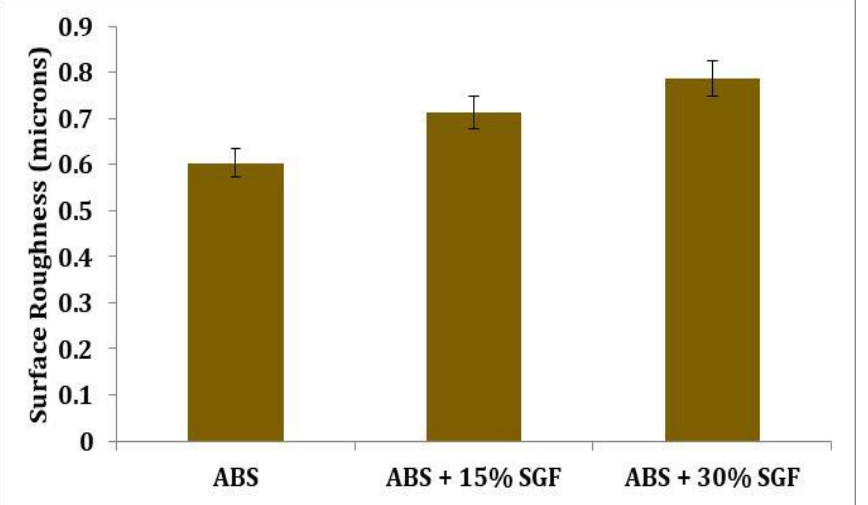
Figure 9. Variation of surface roughness with the addition of short glass